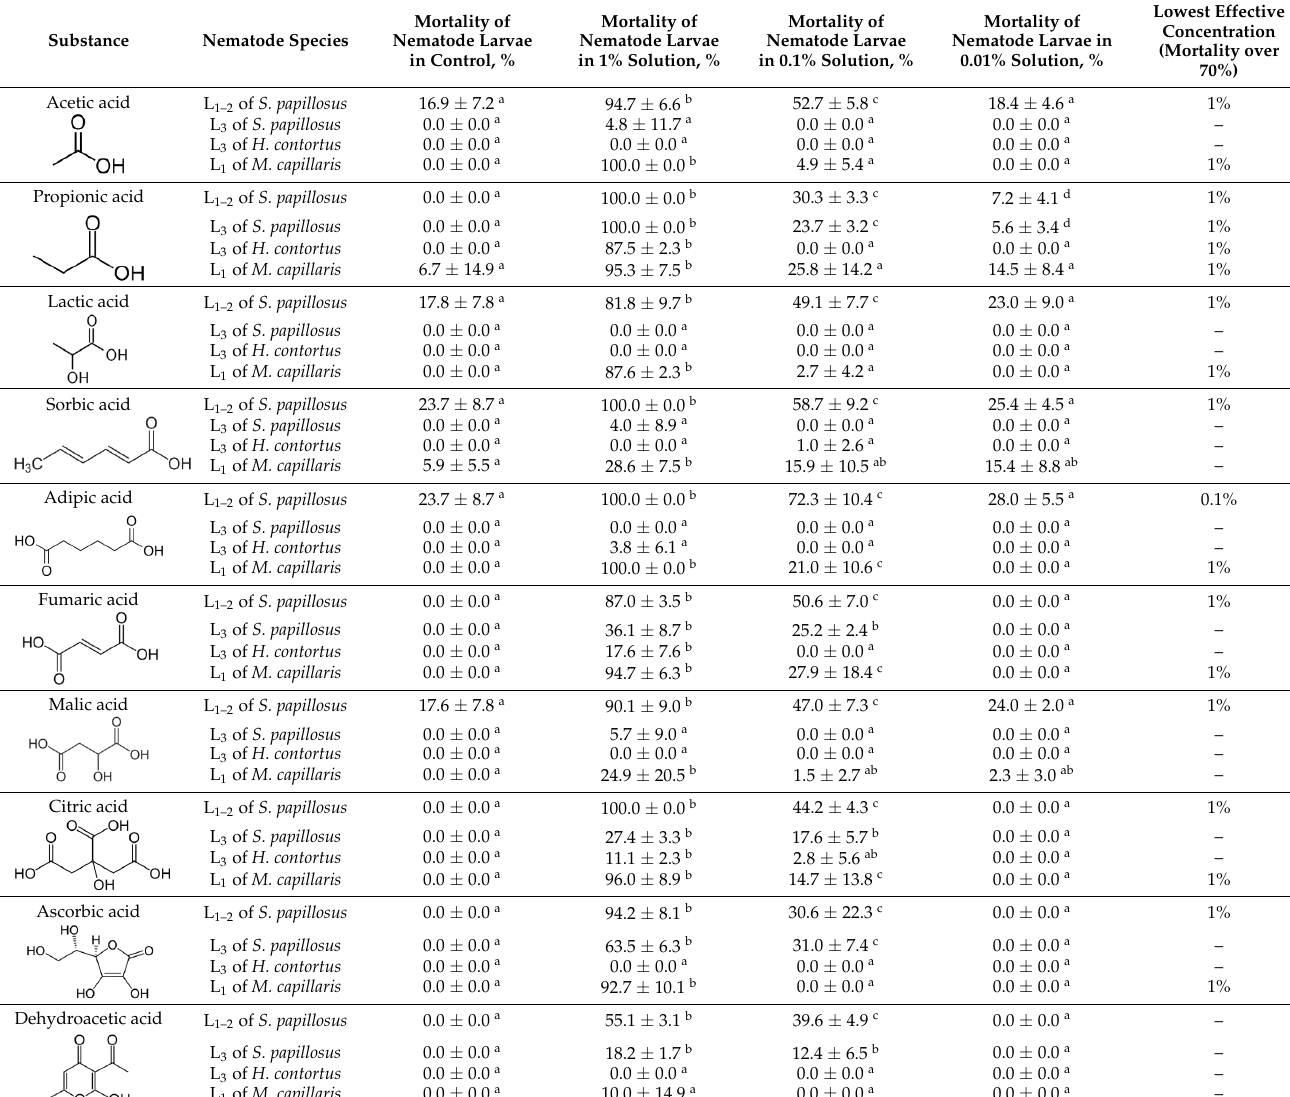
Table 3. Mortality of larvae of S. papillosus , H. contortus , and M. capillaris (%) during 24 h laboratory experiment under the influence of organic acids used as food additives (x ± SD, n = 5).